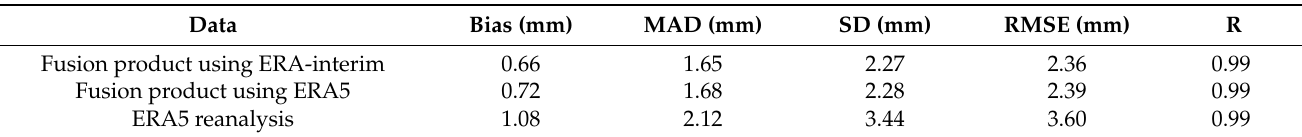
Table 5. Accuracy comparison of fusion products using different background fields in 2018 (including the accuracy of ERA5).